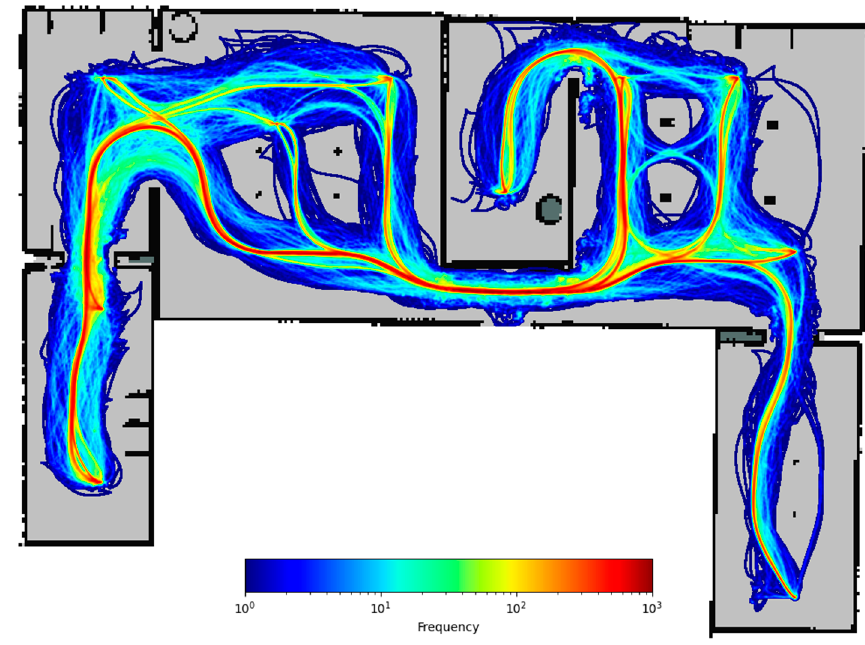
Figure 7. Map and heatmap of robot paths during simulation using logarithmic scale.